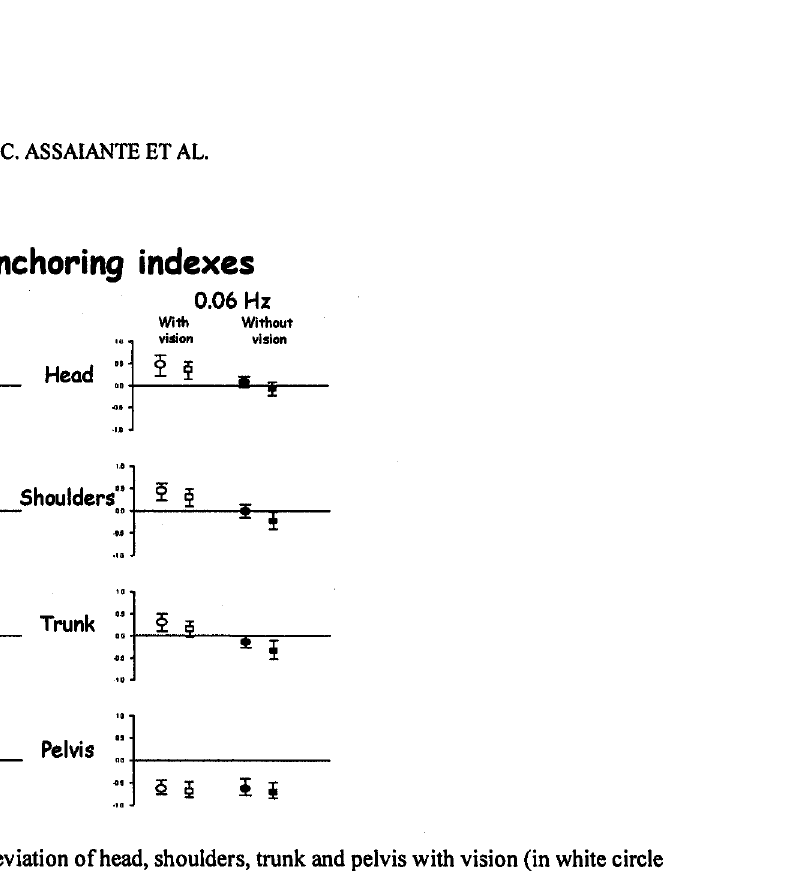
Fig. 4: Mean anchoring indexes and standard deviation of head, shoulders, trunk and pelvis with vision (in white circle for girls and in white square for boys) and without vision (in black circle for girls and in black square for boys) in the case of lateral perturbation ofthe support. Grey squares represent adults without